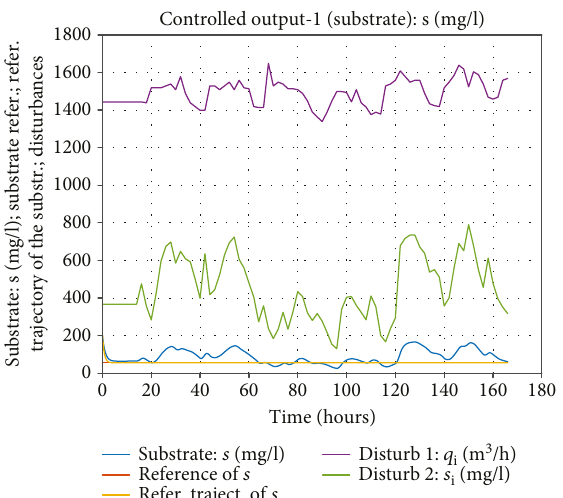
Figure 26: Reactor biomass by FMBPC and disturbances (case